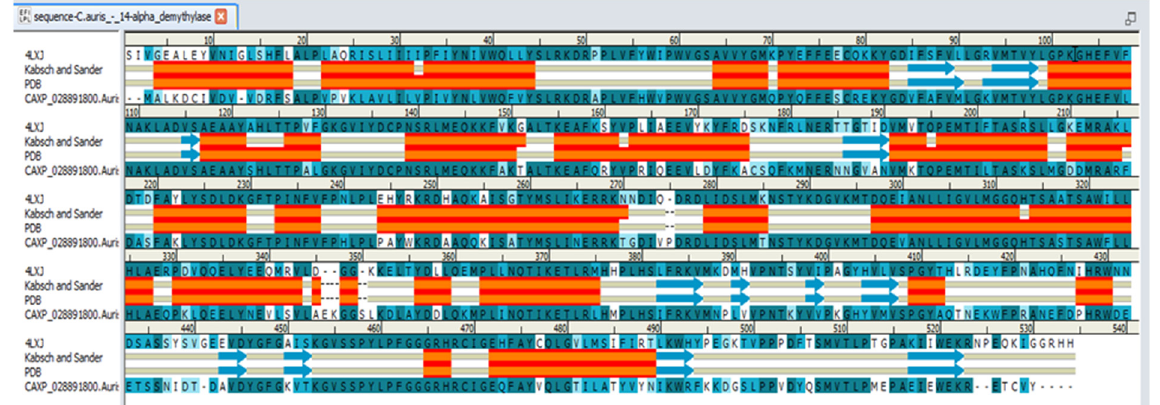
Figure 5. Sequence alignment between C. auris 14- α -demethylase (NCBI Reference Sequence: XP_028891800.1) and S. cerevisiae (PDB: 4LXJ) using align sequence protocol in Discovery Studio 2.5. Amino acid identity is shown in dark blue, and similarity is represented in light blue. Secondary structure of S. cerevisiae 14- α -demethylase is shown. Orange and red zones represent α -helix, blue arrows represent β -sheet.